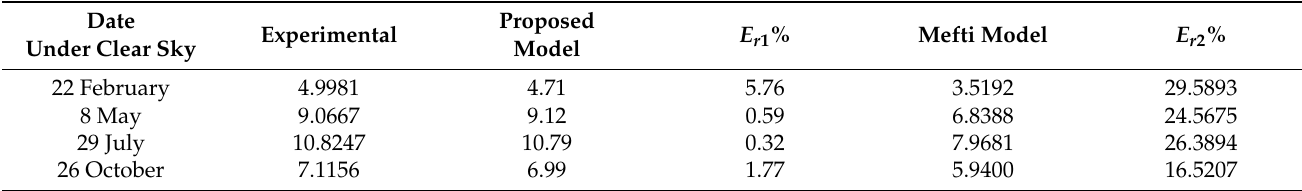
Table 9. Results for Tlemcen site (KWh/m 2 ).